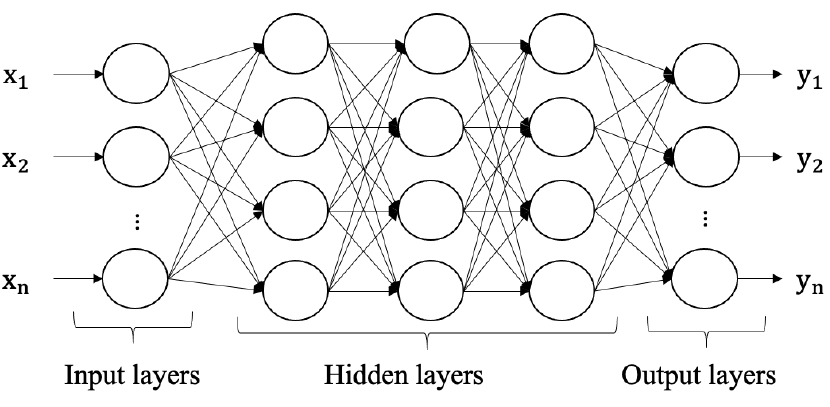
Figure 9. Structure of DNN.